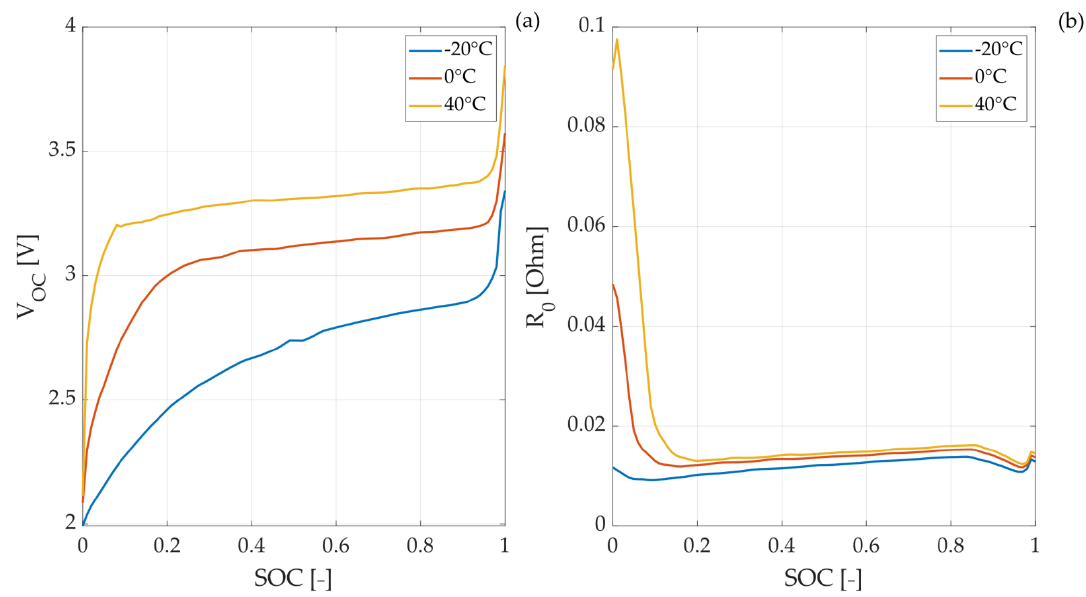
Figure 3. Battery cell characteristics: ( a ) cell open-circuit voltage V OC vs. SOC ; ( b ) internal resistance R 0 vs. SOC. Table 1. Main parameters of the retained battery model.